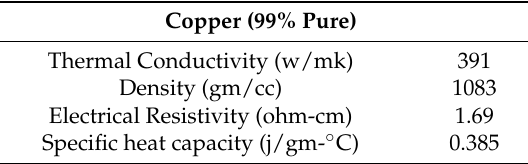
Table 3. Mechanical properties of electrode.